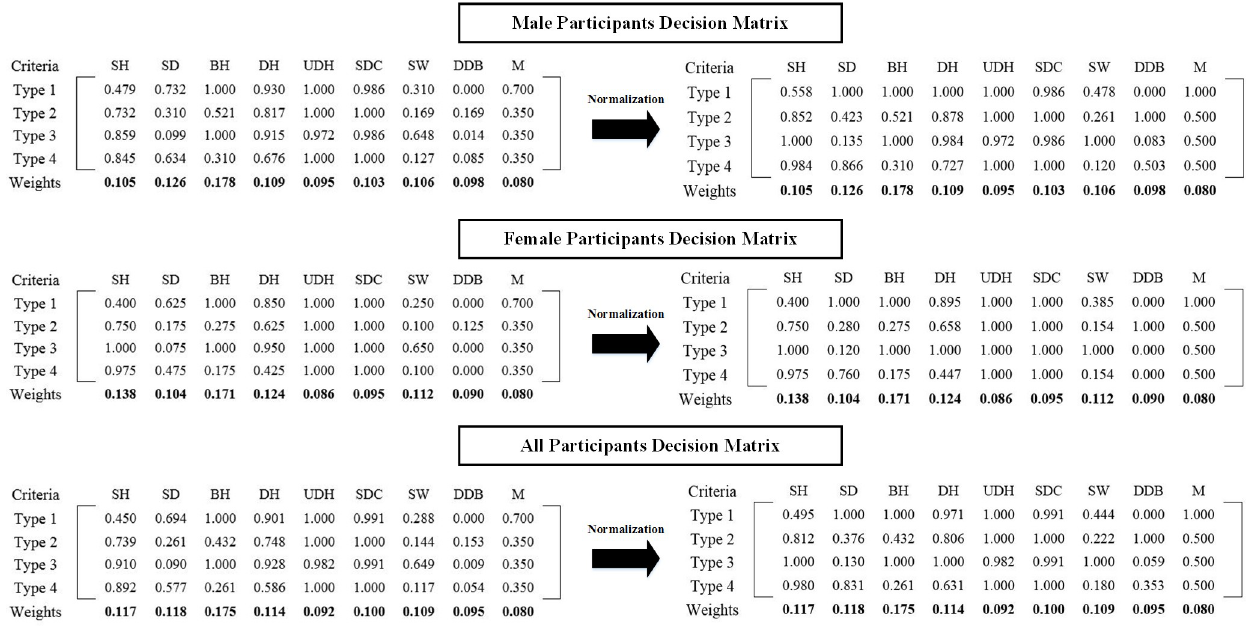
Fig 9 indicates that Type 1 furniture is the best existing chair with an attached table in this study, and Type 3 furniture is in the second rank. However, if only female participants consid- ered as DMs, Type 3 furniture is the best existing furniture, and Type 1 will be second. In all conditions, Type 2 and Type 4 will be in the third and fourth rank, respectively. FAM Scores in Fig 9 represent that if OIFC Score ignored, Type 3 would be the best current furniture for